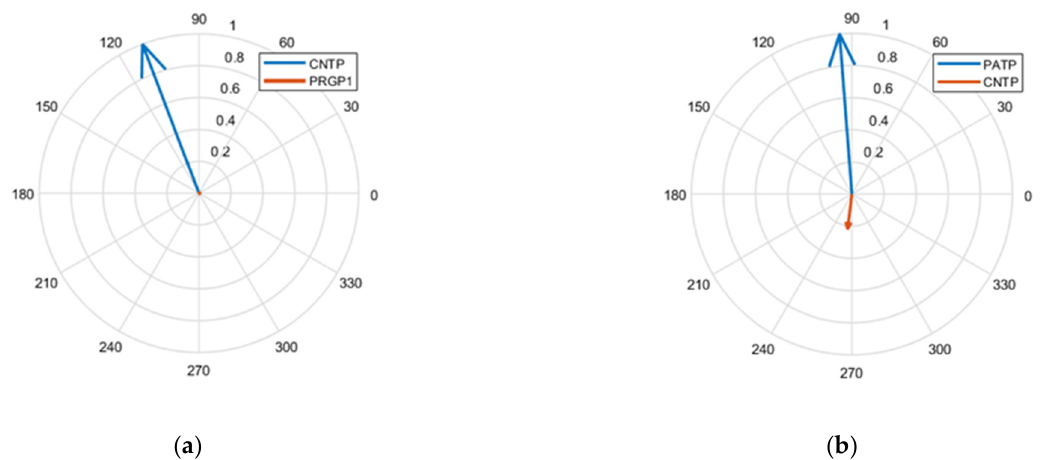
Figure 15. Low Load DP: ( a ) oscillation vector of mode M6; ( b ) oscillation vector of mode M7. The Lines out of Service DP being a variation of the Low Load one, in which two important 230 kV lines (lines Favara-Chiaramonte and Caracoli-Sorgente) are out of service, presents the same three modes. The results are reported in Table 13. Mode M1 is particularly affected because the line Caracoli-Sorgente effectively connects the plant in Termini Imerese (TIMP) to the interconnection with continental Italy, right before the substation of Rizziconi. Table 13. Electromechanical modes below the threshold of 10% for the Lines out of Service DP. Mode Eigenvalues Frequency (Hz) Damping (%) Involved Plants M1